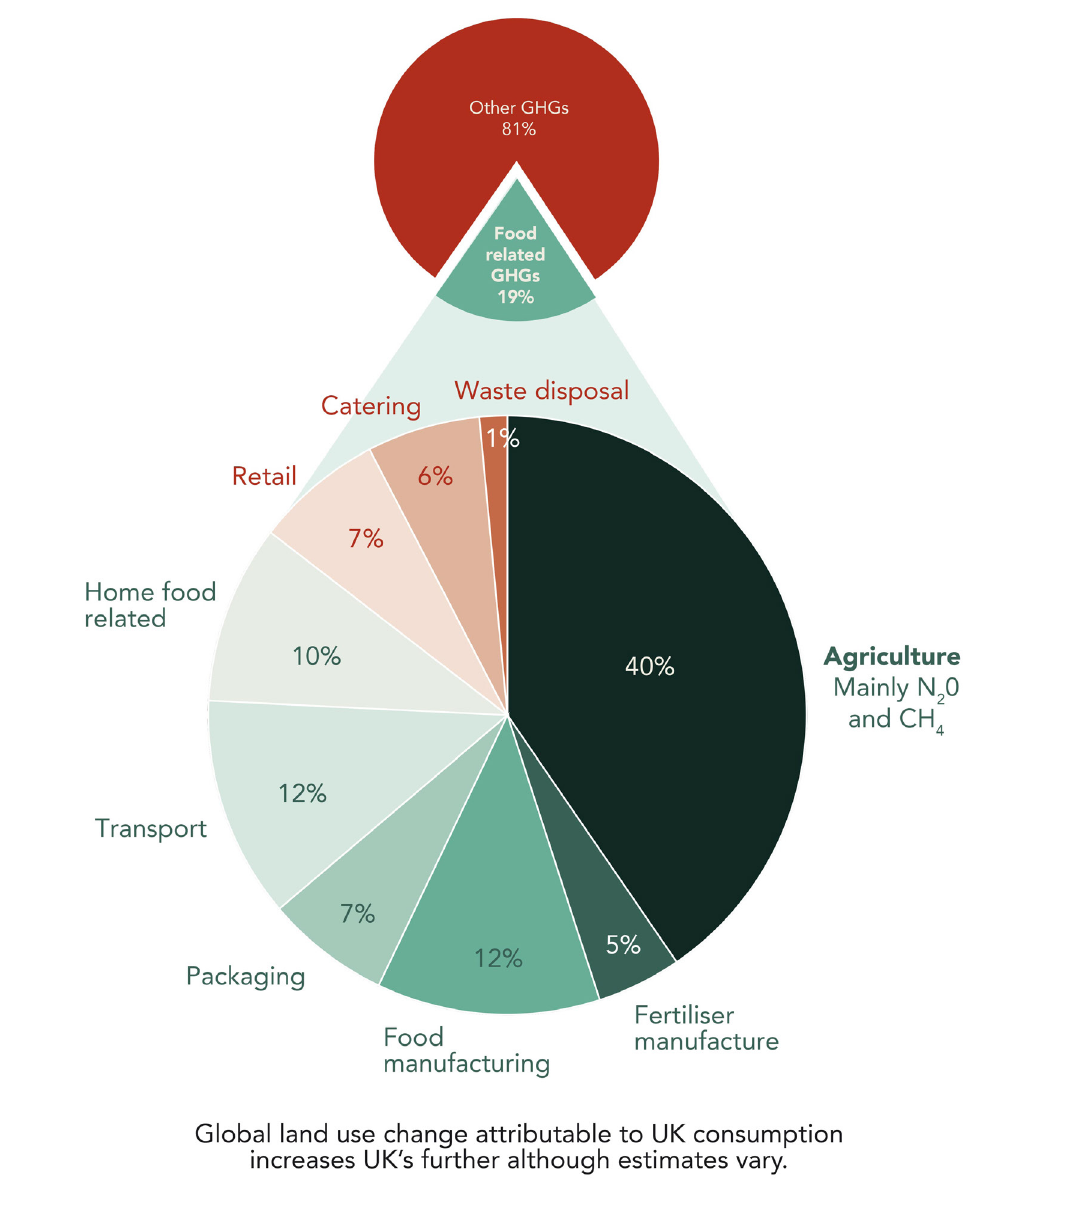
Figure 4: The contribution of the food system to UK emissions – excluding land use